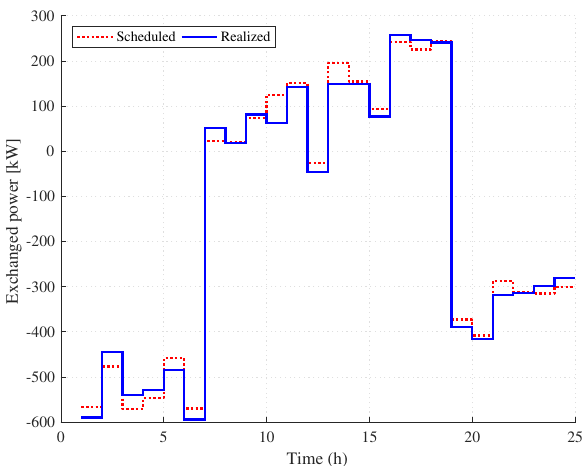
Figure 6. MMG system and main